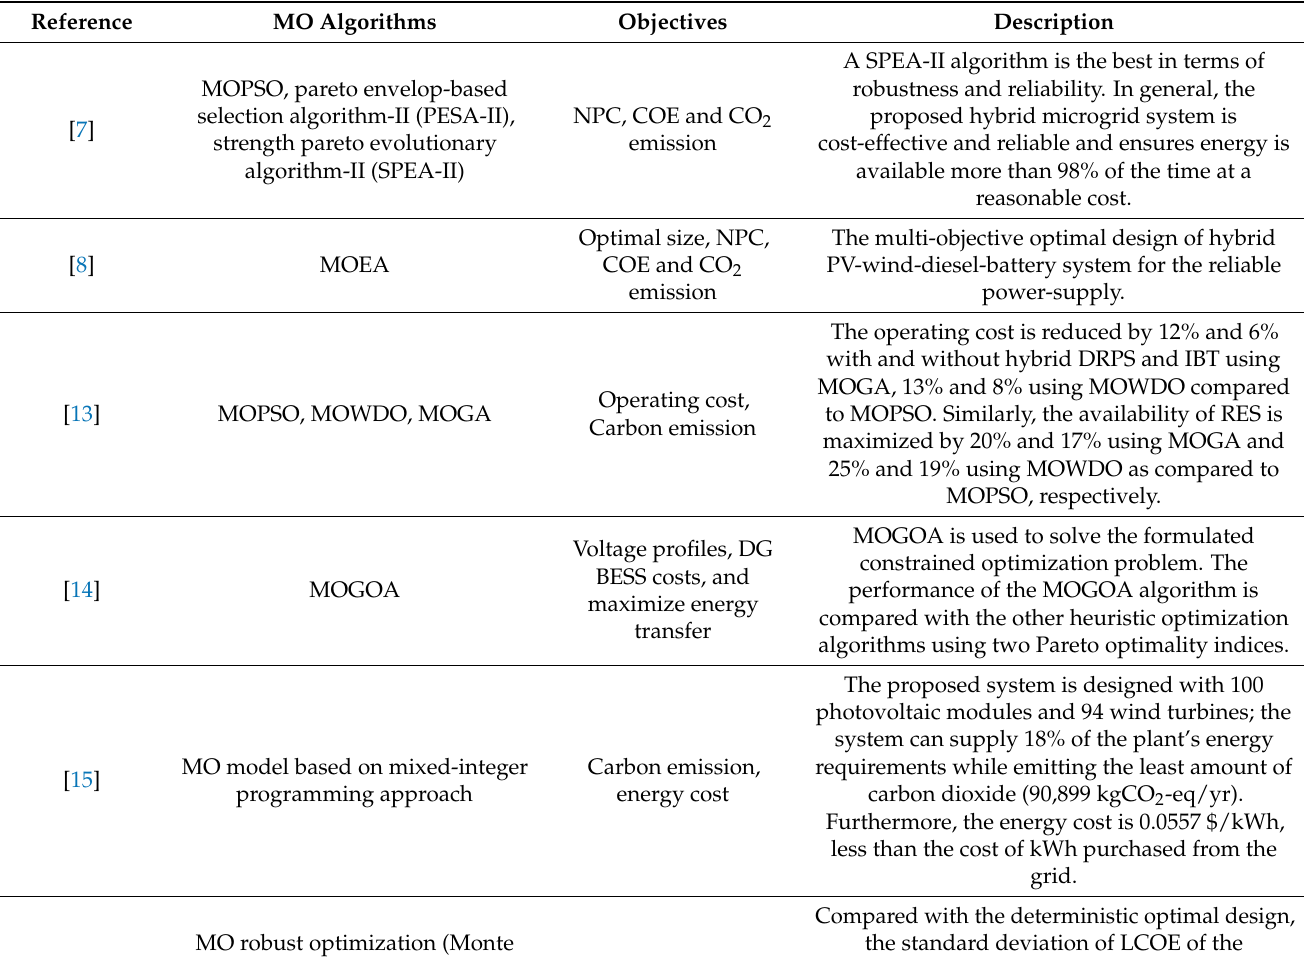
Table 4. Performance evolution of each MOO